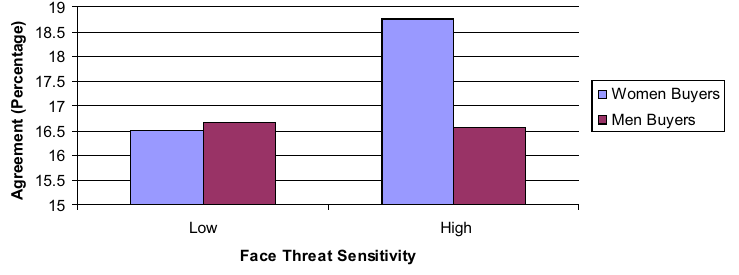
Figure 1. Interaction of